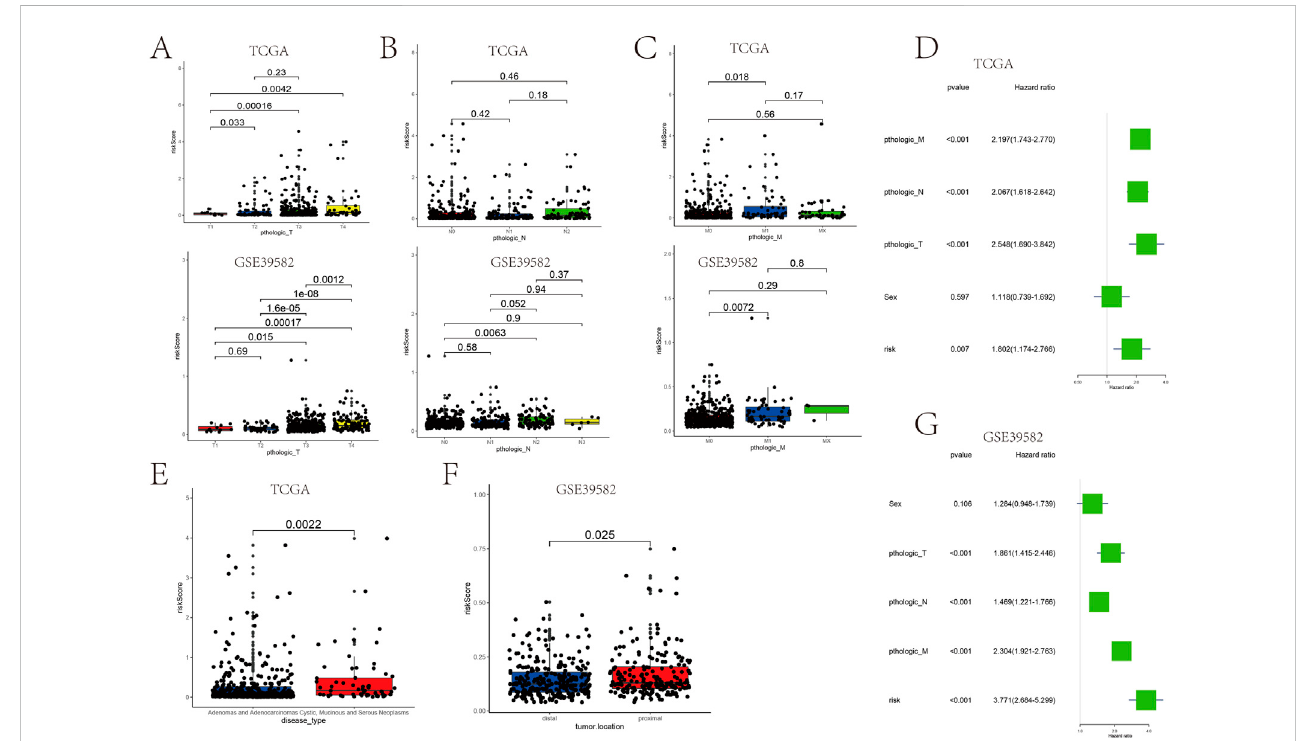
FIGURE 7 Association between the risk score and the patient ’ s clinical characteristics. (A – C) Association between the tumor size (T), tumor node (N), tumor metastasis (M), andriskscore inTCGAcohortand GSE39582. (D) Univariate analysis offactors in fl uencing patient prognosis inTCGAcohort. (G) Multifactorial analysis of factors in fl uencing GSE39582 patient prognosis. (E) Relationship between the disease type and risk score. (F) Relationship between the tumor location and risk